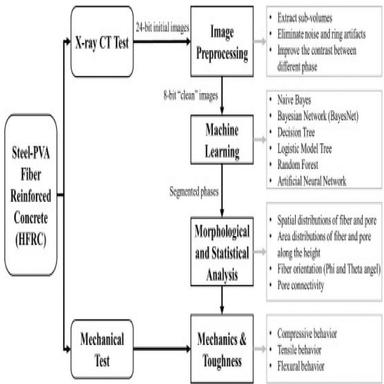
Flowchart of investigating the 3D microstructure and its impact on mechanical properties of HFRC. Image reproduced from.